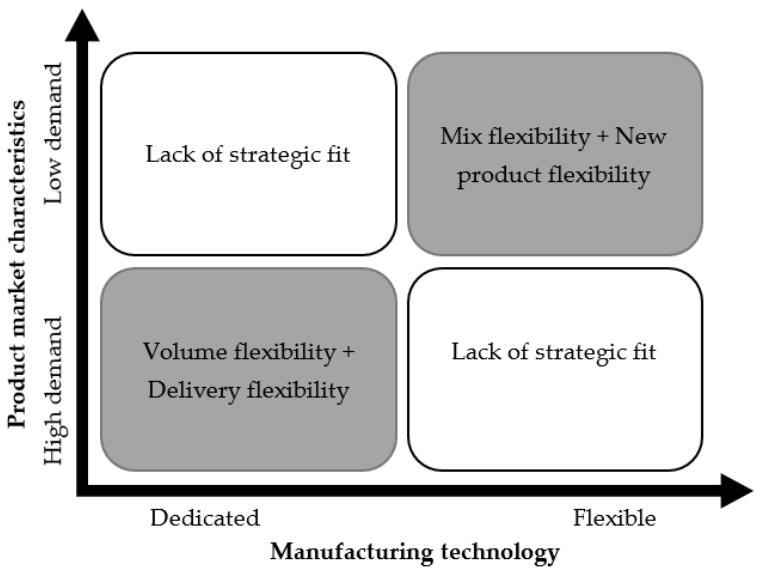
Figure 8. The relationship between the external flexibility capabilities, manufacturing technology and demand volume